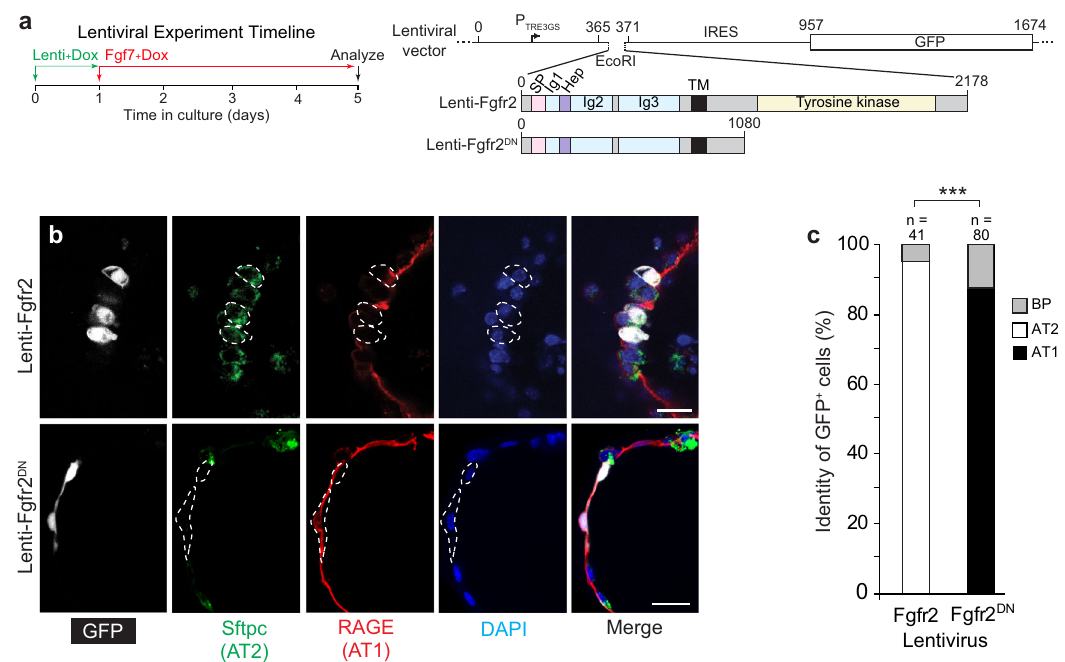
Fig.3|Fgfr2signalingcontrolsAT2fateselectioncellautonomouslyinculture. a Experiment timeline and structures of lentiviral vectors co-expressing wild-type Fgfr2 (Lenti-Fgfr2) or dominant negative Fgfr2 lacking the tyrosine kinase domain (Lenti-Fgfr2 DN ) and GFP. Numbers above the vector indicate nucleotide position and above Fgfr2 structure indicate amino acid residue; colors highlight functional domains in Fgfr2. TRE tetracycline responsive element, IRES internal ribosome entry site, GFP green fl uorescent protein, SP signal peptide, Ig immunoglobulin domain, Hep heparin sulfate binding domain, TM transmembrane domain, DN dominantnegative. b e16.5alveolarprogenitorsweremosaicallyinfected(lessthan 1% of the cultured cells were infected) with the lentiviral vectors indicated at the time of cell plating in doxycycline-containing media (100ng/ml) for 24h, then